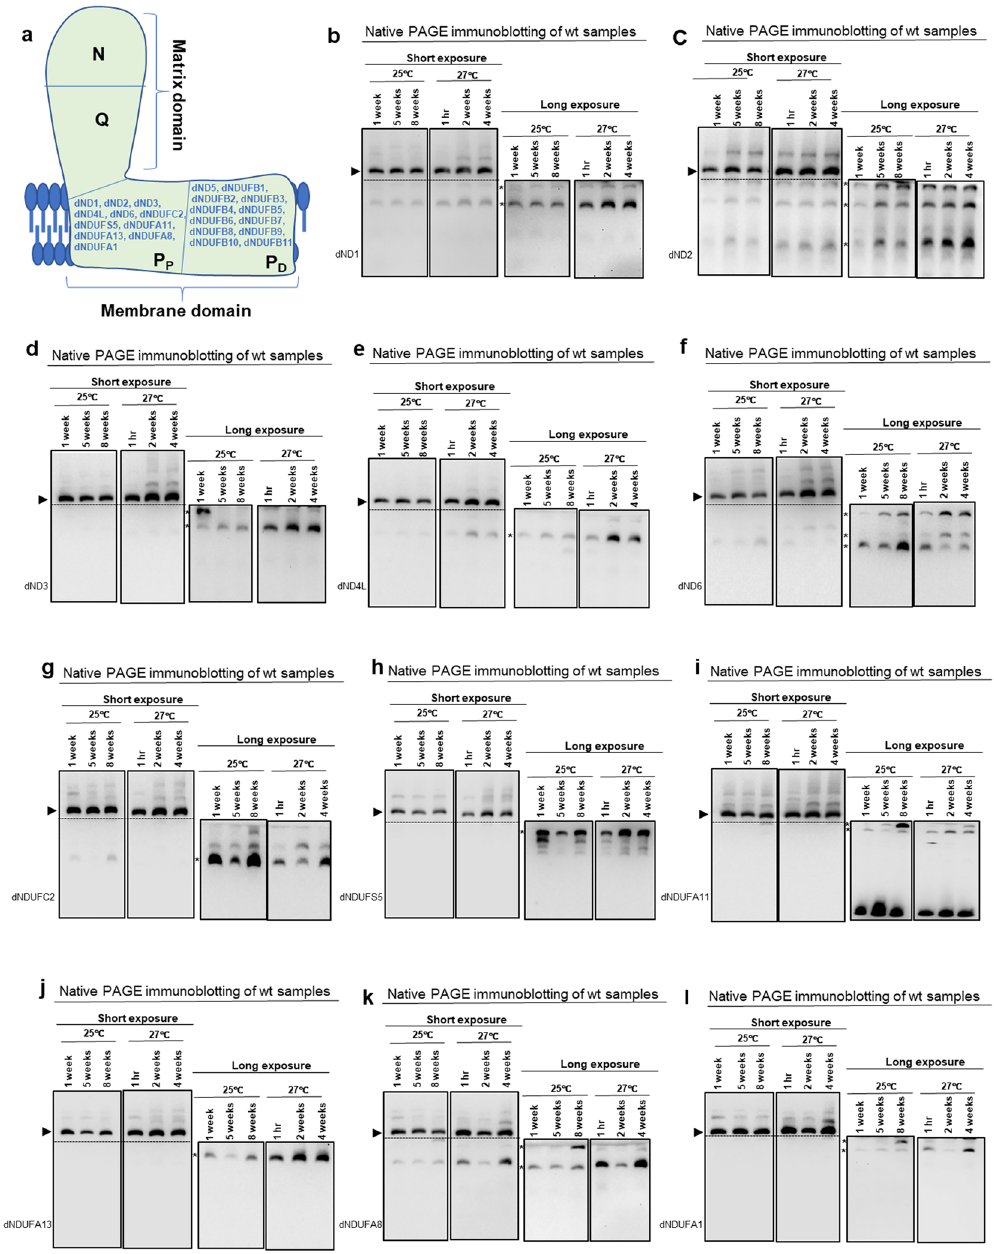
Figure 3. A variable wave of up-regulation of several P P -module subcomplexes occurs during muscle aging. ( a ) A diagram of mitochondrial CI showing the antibodies used to monitor the synthesis of the P P -and P D - modules. ( b – l ) Mitochondrial preparations obtained from thoraces of wt flies at the time points and temperatures indicated were analyzed by BN-PAGE, followed by Western blotting. The antibodies used were anti-dND1 ( b ), anti-dND2 ( c ), anti-dND3 ( d ), anti-dND4L ( e ), anti-dND6 ( f ), anti-dNDUFC2 ( g ), anti- dNDUFS5 ( h ), anti-dNDUFA11 ( i ), anti-dNDUFA13 ( j ), anti-dNDUFA8 ( k ), and anti-dNDUFA1 ( l ). See Fig. S5 for replicates and S7 for full-length gels and